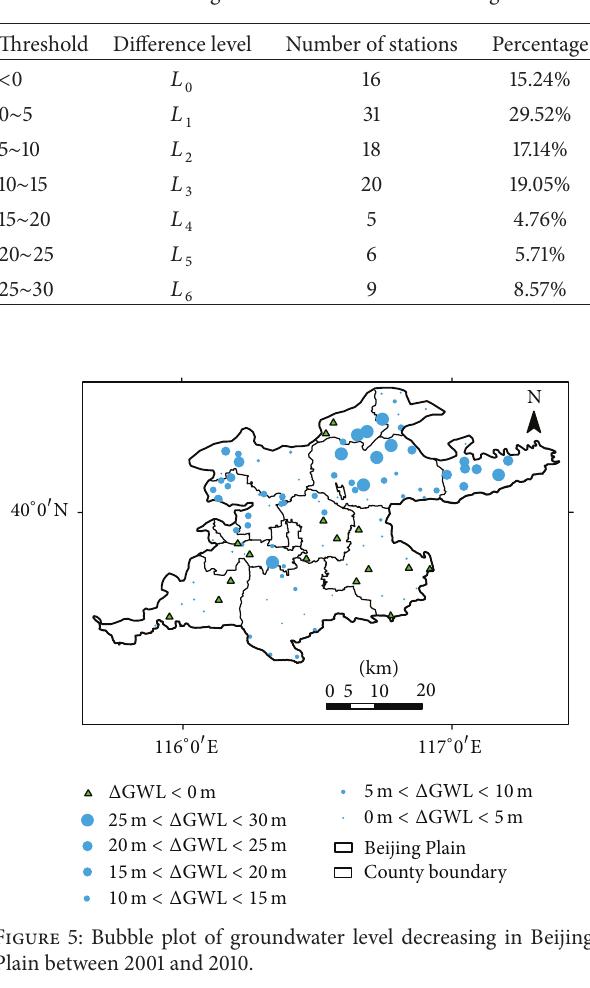
Figure 5: Bubble plot of groundwater level decreasing in Beijing Plain between 2001 and